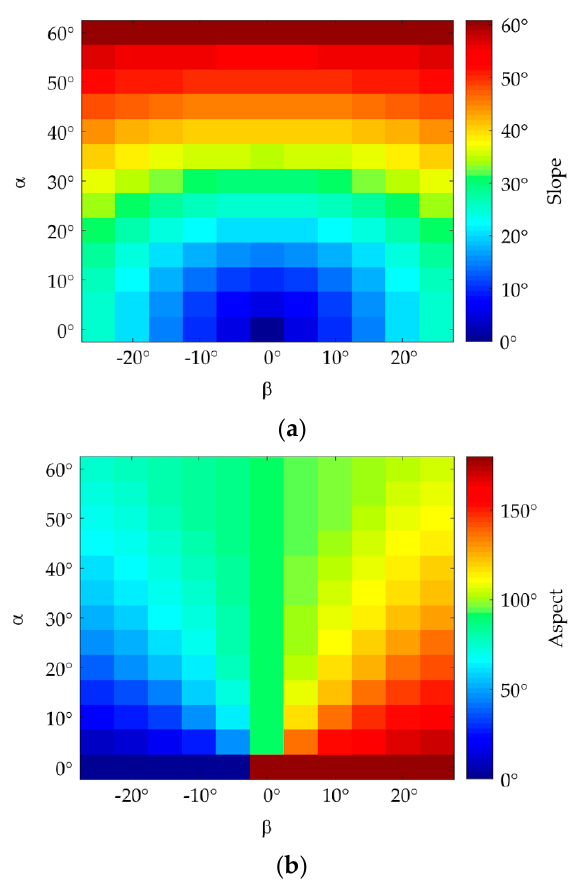
Figure A1. Terrain slope ( a ) and aspect ( b ) values as a function of angles α and β .